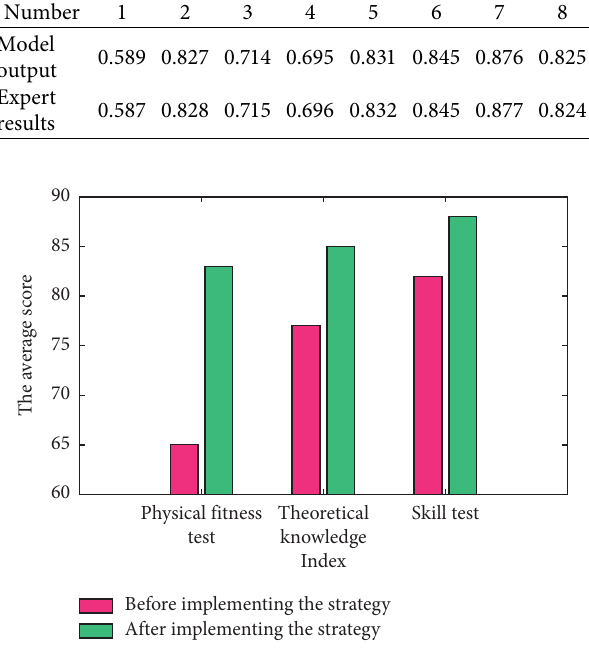
Figure 6: Te average score of each indicator before and after implementing the